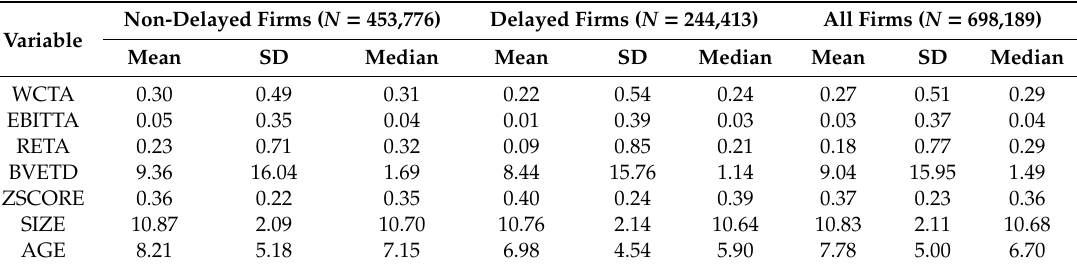
Table 2. Descriptive statistics of the